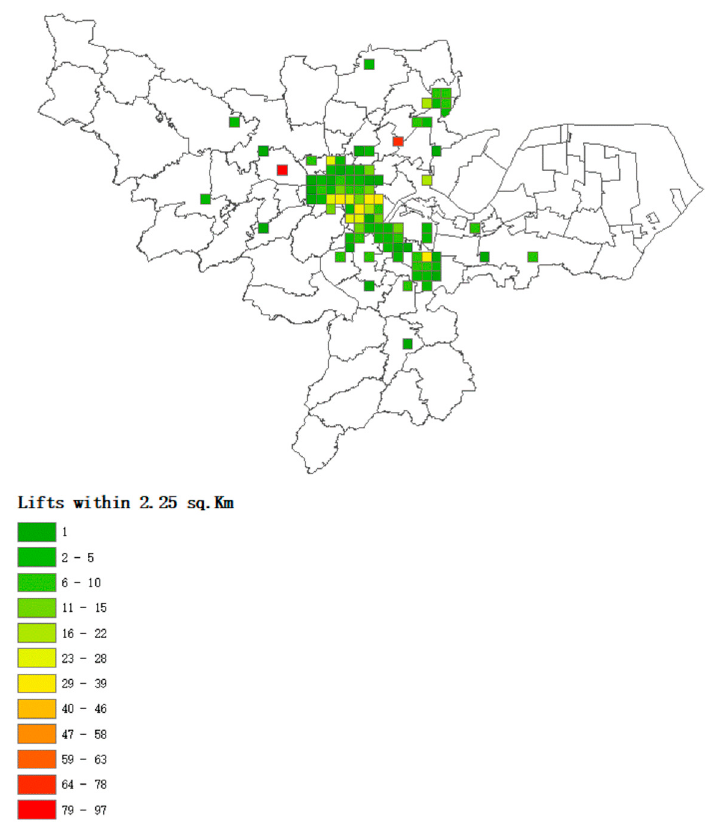
Figure 3. Fishnetting reveals the patterns of adoption of Lifts in 2020.